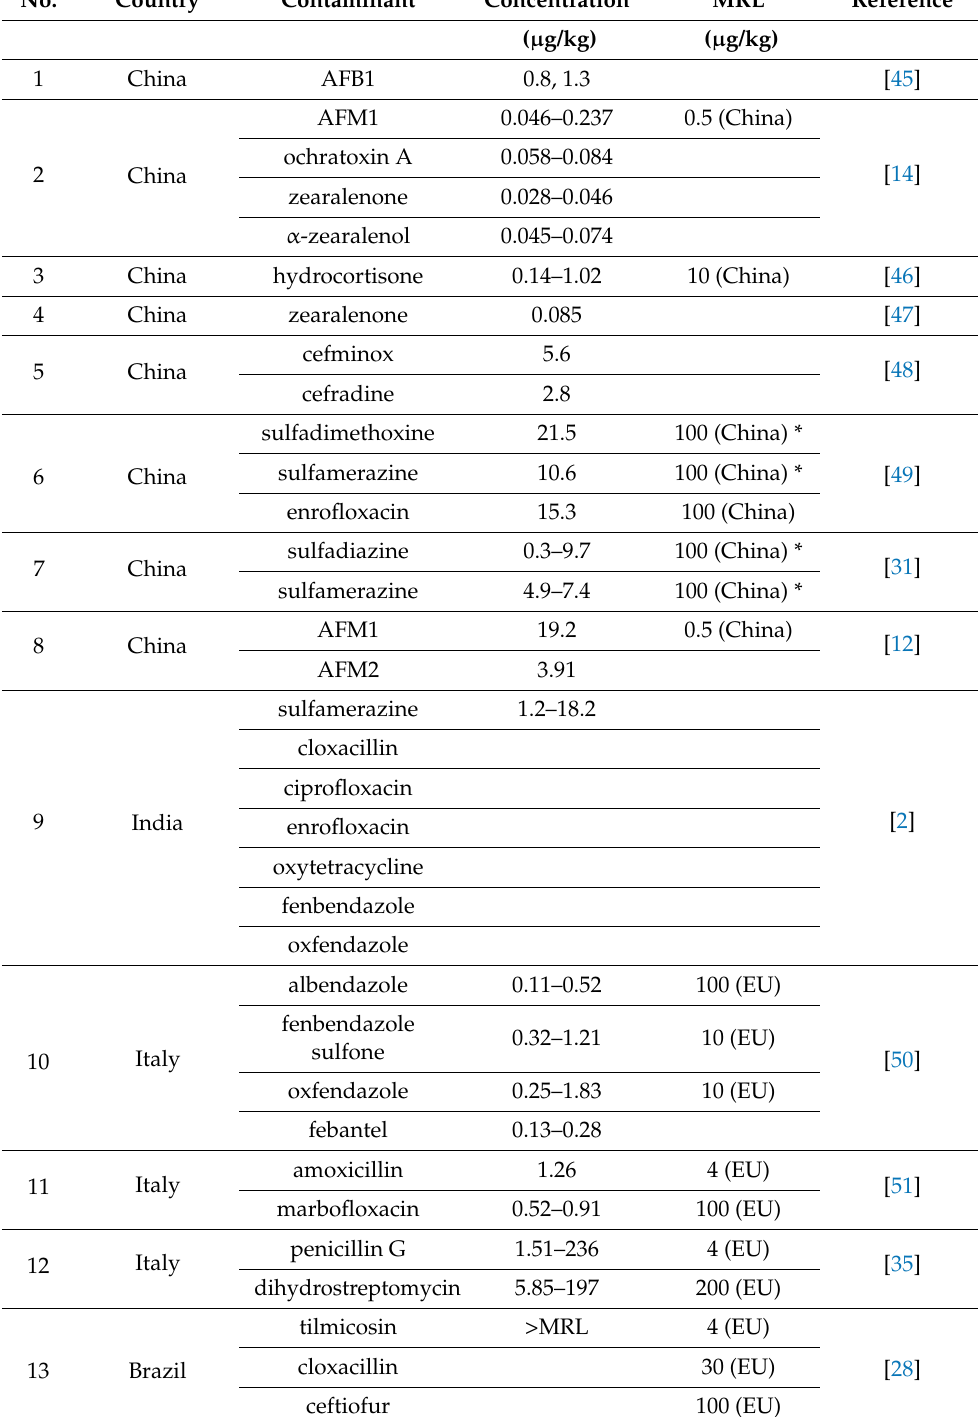
Table 2. The contaminant concentration in milk from the different countries from the literature. No. Country Contaminant Concentration MRL Reference ( µ g/kg) ( µ